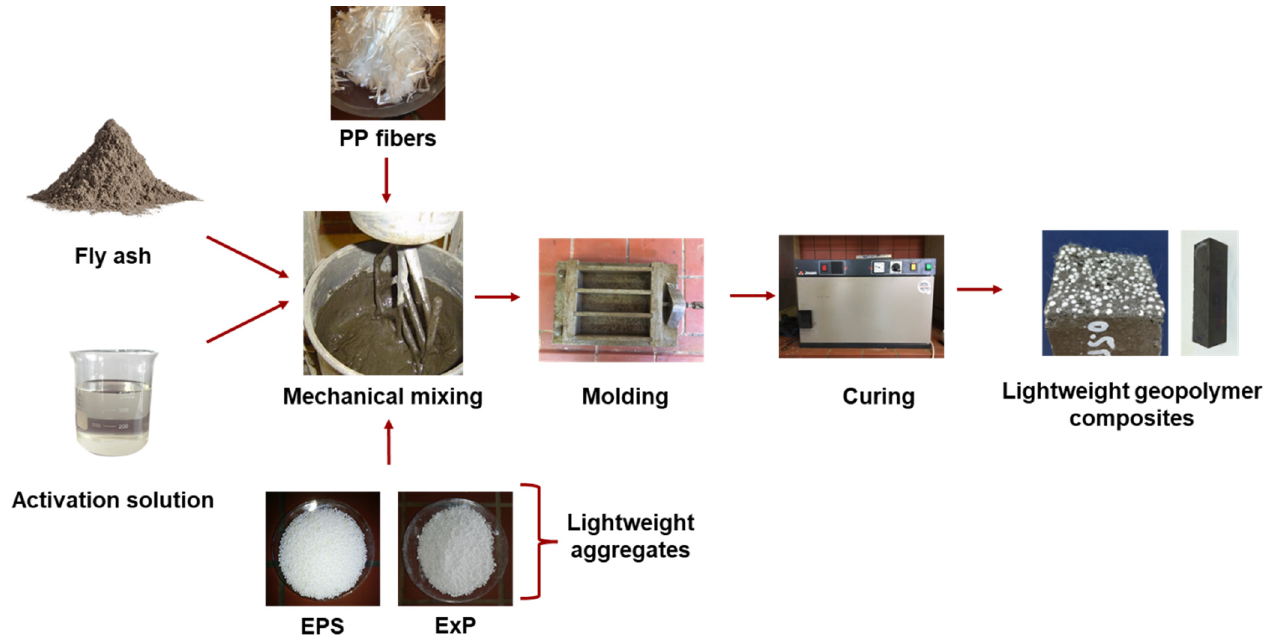
Figure 3. Synthesis procedure followed in this study. Table 3. Geopolymeric samples prepared in this